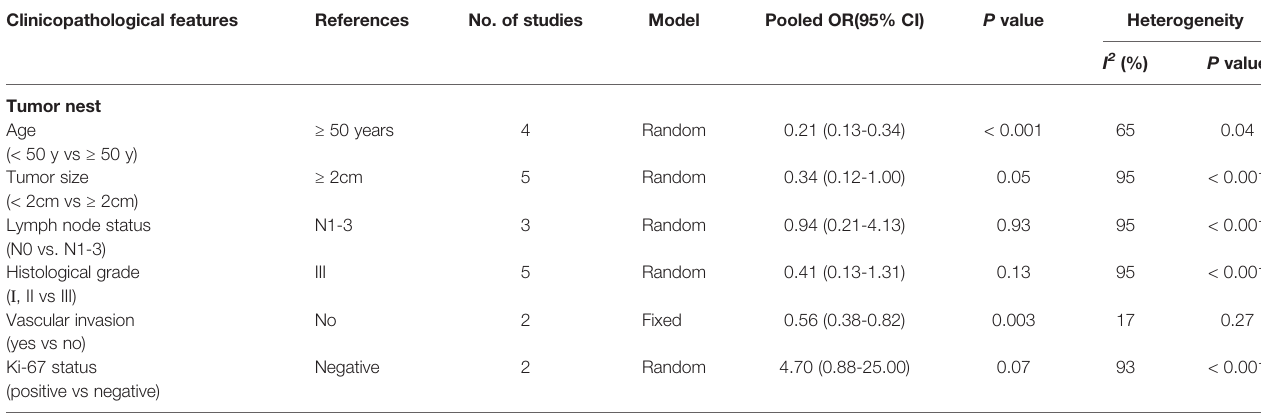
TABLE 3 | Meta-analysis of high CD163+ TAMs density and clinicopathological features of breast cancer patients. Clinicopathological features